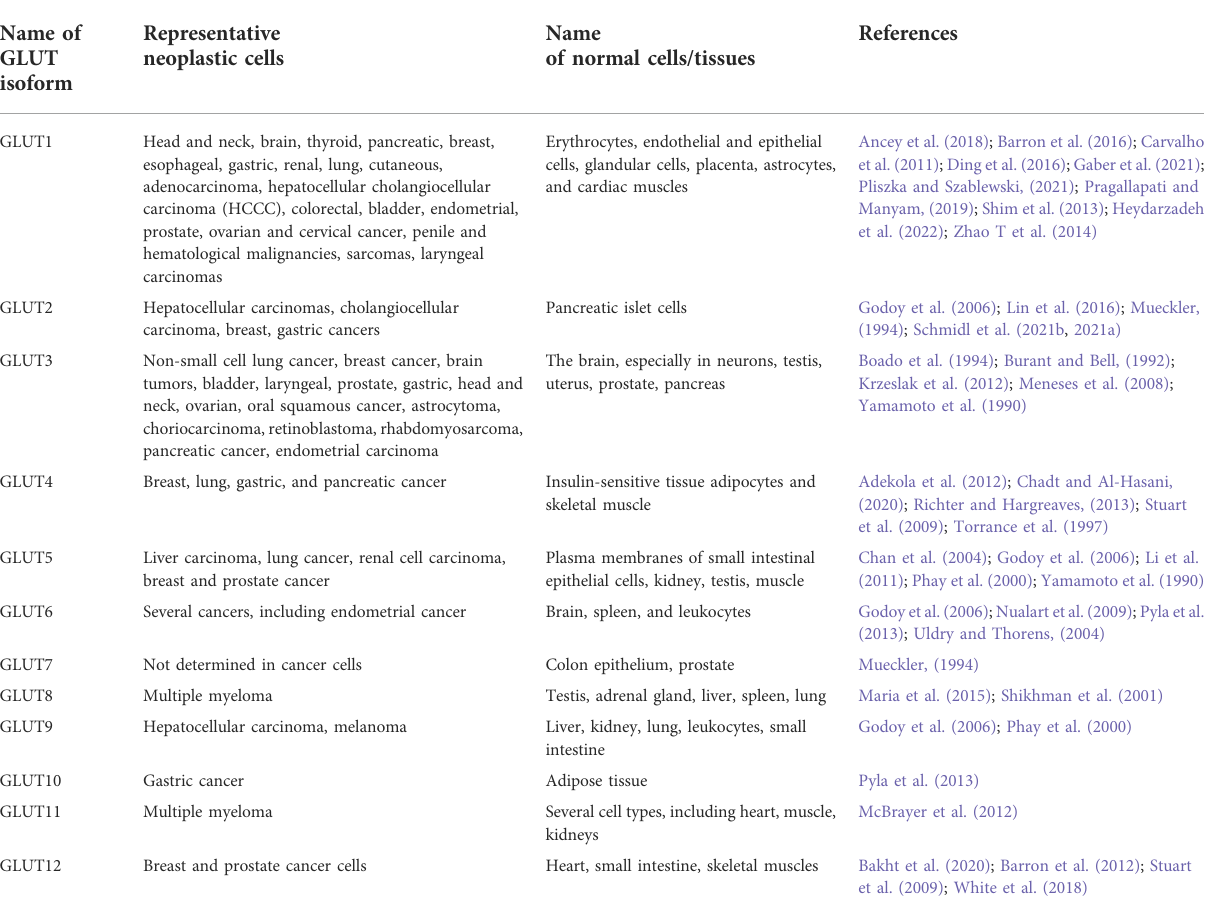
TABLE 1 Cancer genome-based representative distribution of GLUTs in various cancer